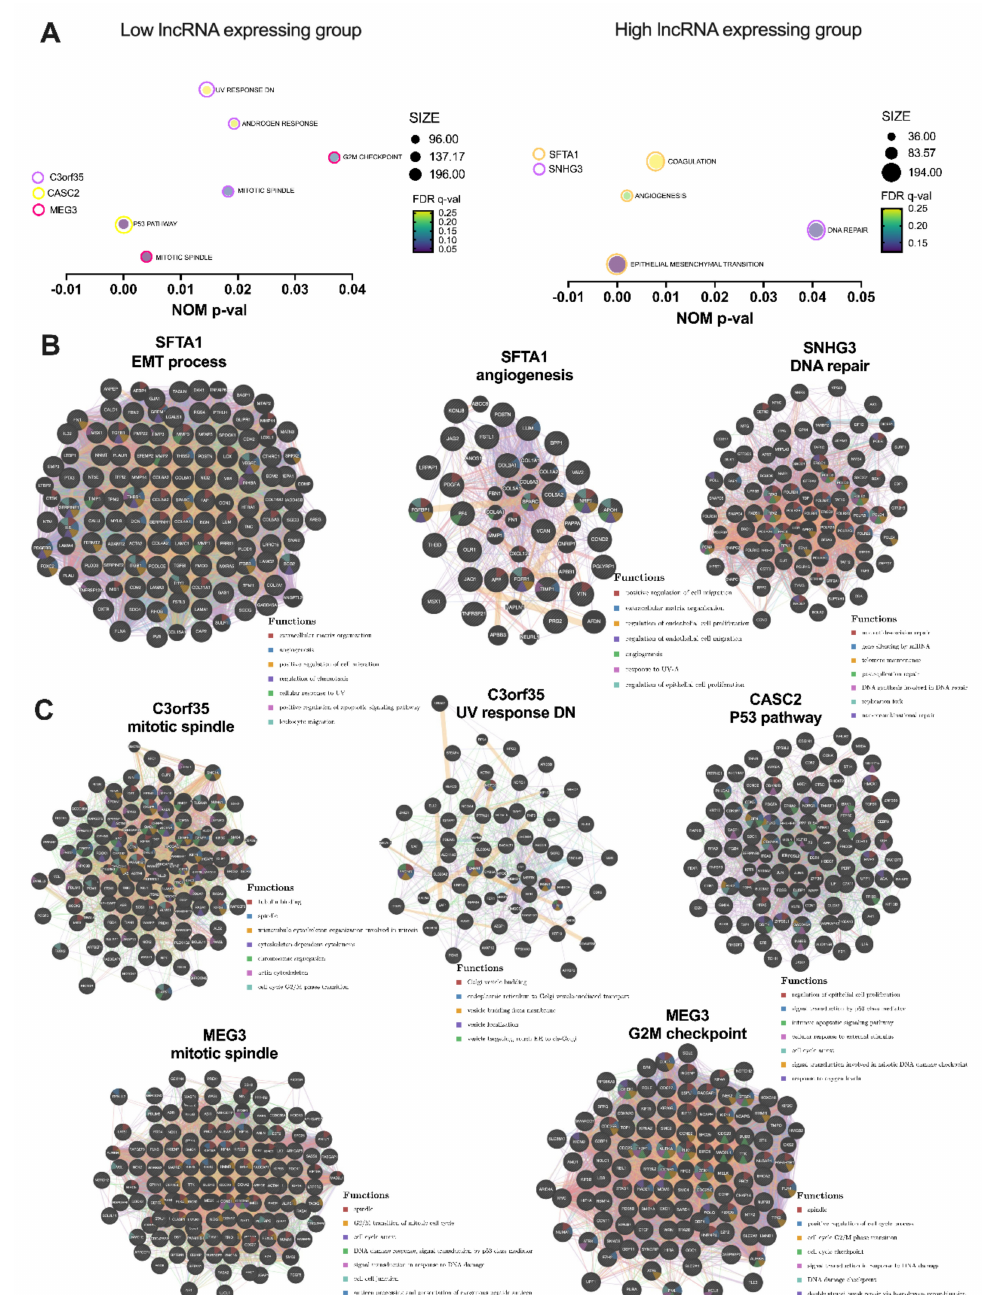
Figure 4. Pathways and cellular processes associated with expression level of C3orf35, CASC2, MEG3, SFTA1P, and SNHG3 lncRNAs: ( A ) Gene set enrichment analysis (GSEA) analysis of genes enriched in the set of 150 HNSCC patients (RG and NRG groups) depending on expression level of specified lncRNA (high or low groups divided based on the median expression of lncRNA); only the gene sets with nominal p < 0.05 were presented; NES -normalized enrichment score, FDR q-value-false discovery rate, SIZE-number of enriched genes in a specified process; and further analysis of genes included in GSEA results ( FDR < 0.27 and p < 0.05) for ( B ) genes enriched in the group of patients with higher level of SFTA1 and SNHG3 lncRNAs, and ( C ) lower level of C3orf35, CASC2, and MEG3, and connected with ionization radiation response; GeneMANIA tool; p < 0.05 considered as statistically